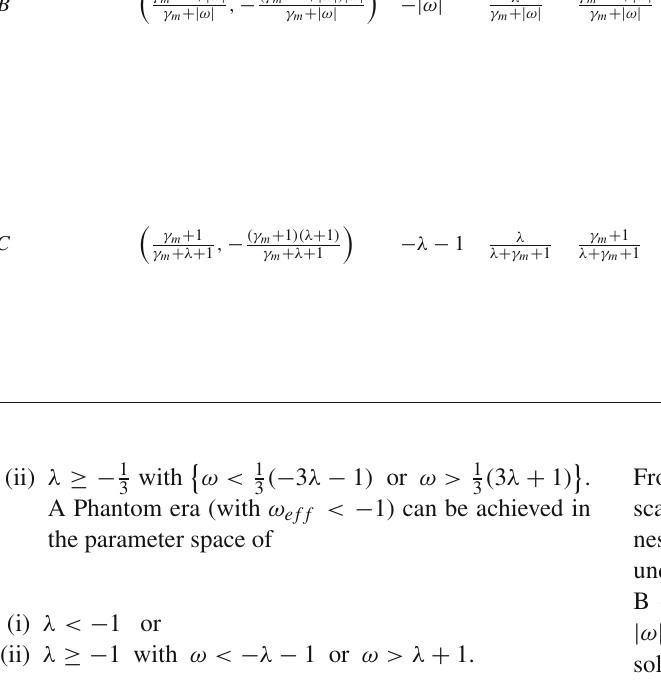
+ 3 λ Always saddle, since 2 2 0 ≤ λ ≤ γ m . Stable node for: , − γ + λ < ω < λ + 1 , or λ ≥ γ m m 0 ≤ λ < γ m , 0 ≤ ω < λ + 1, or , − λ − 1 < ω < γ − λ , or λ ≥ γ m m 0 ≤ λ < γ m , − λ − 1 ≤ ω < 0 Saddle node for: | ω | > 1 + λ, λ ≥ 0 . Stable node for: 0 ≤ λ < | ω | − 1 , | ω | > 1 . Saddle node for: | ω | ≥ 1 , λ > − 1 + | ω | ,